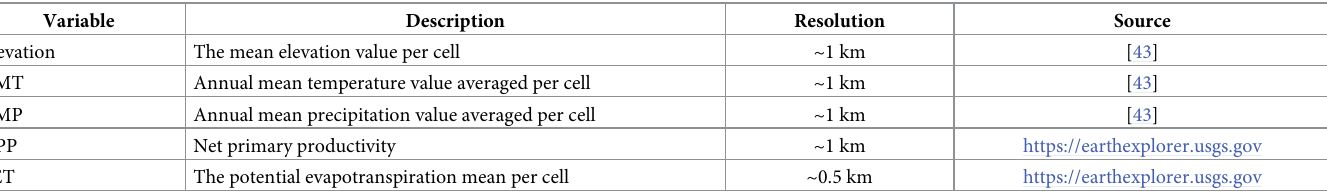
Table 2. Environmental variables used to evaluate the relationship between the species richness and the functional diversity in cricetid rodents in Oaxaca, Me´xico.